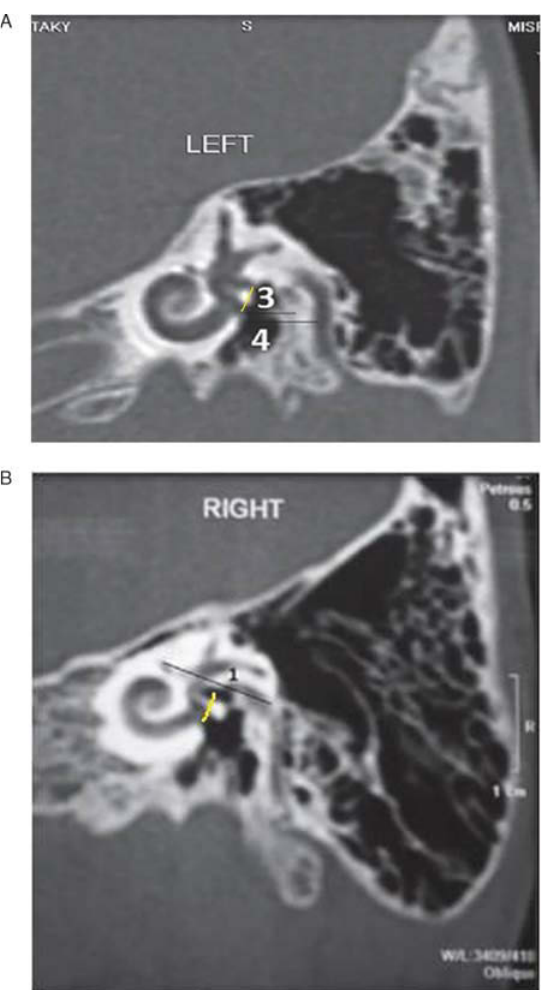
Oval window – round window distance distance (yellow) in oblique sagittal views (a) normal cochlea, (b) dwarf cochlea.